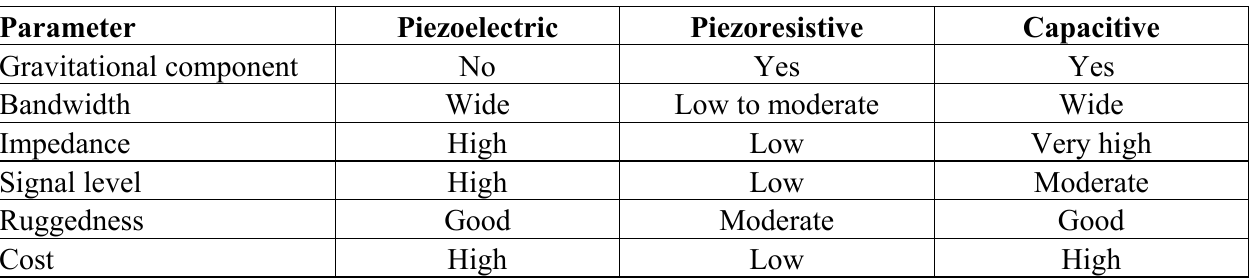
Table 4. Comparison of